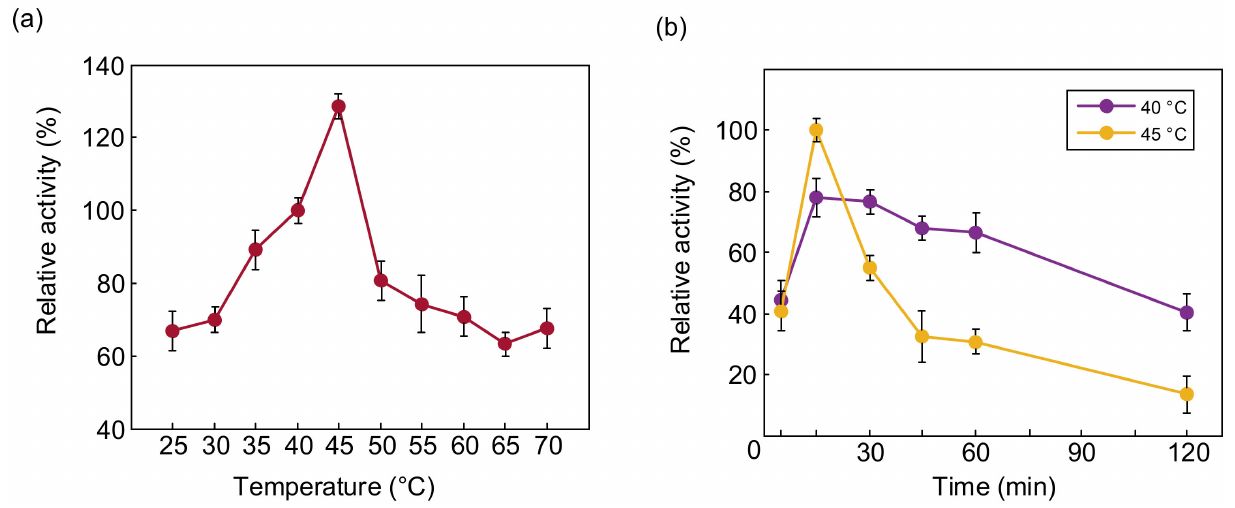
Figure 5. ( a ) Effect of temperature on the relative activity of purified PTCL1-EstA; ( b ) effect of temperature on the stability of purified